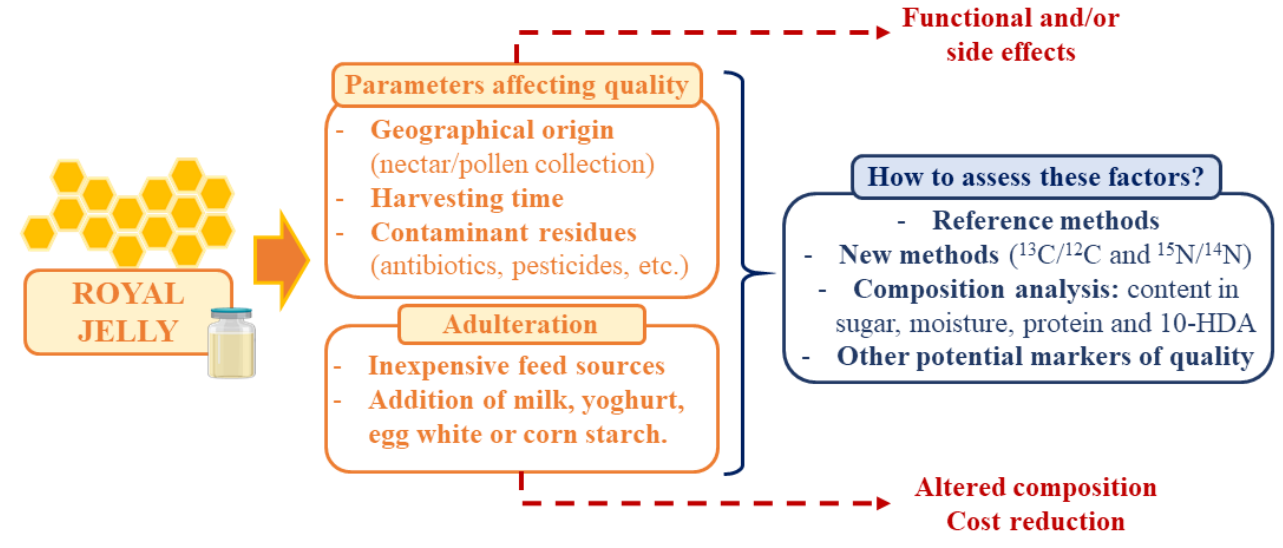
Figure 2. Summary of the main parameters affecting RJ quality, adulteration techniques and measures to assess these factors and guarantee the final quality of the product.